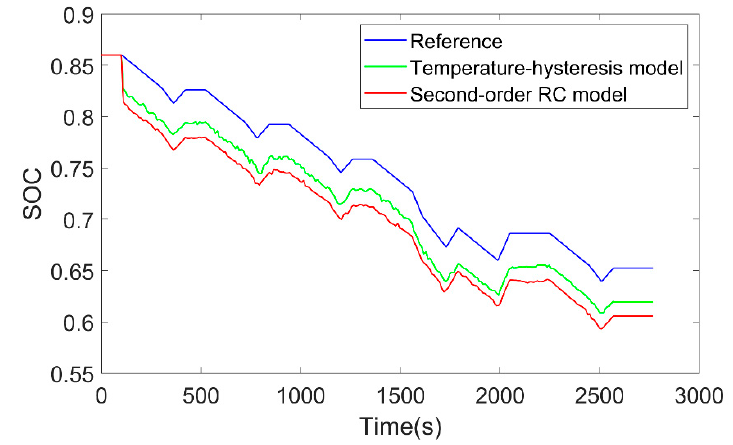
Figure 20. SOC estimation based on different models under variable temperature conditions.